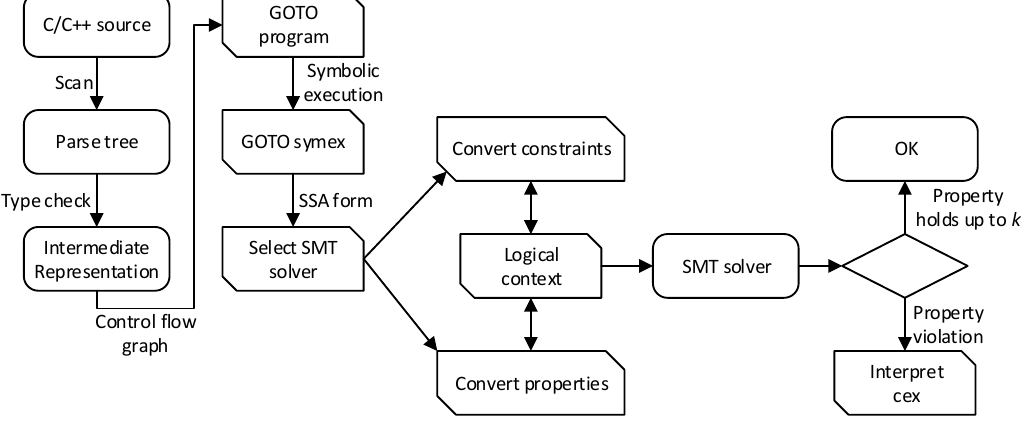
Figure 6. ESW-CBMC internal flow